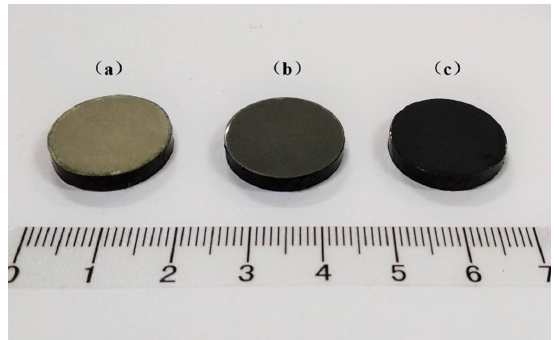
Figure 3: Image of coating specimens: a) Pure-EP; b) EP/ MoS 2 ;